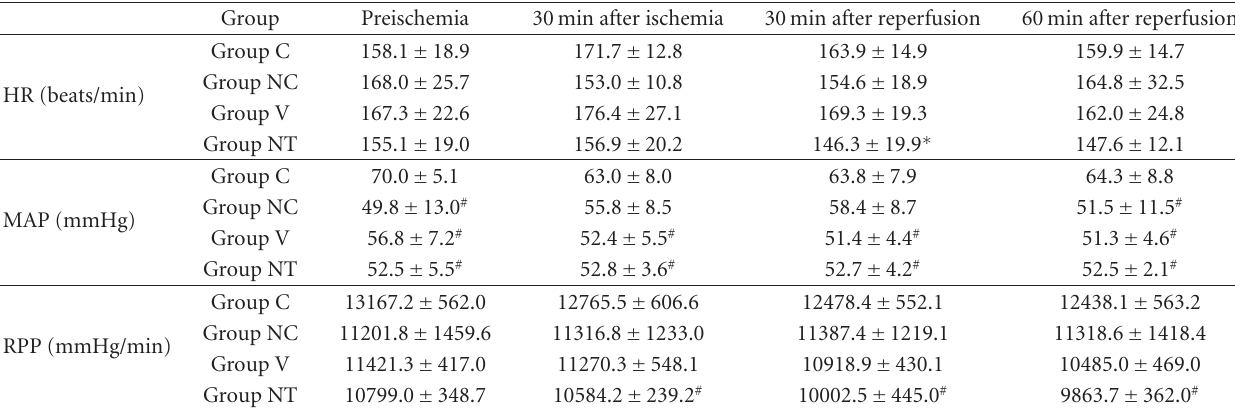
Table 1: Hemodynamics during ischemia and reperfusion.